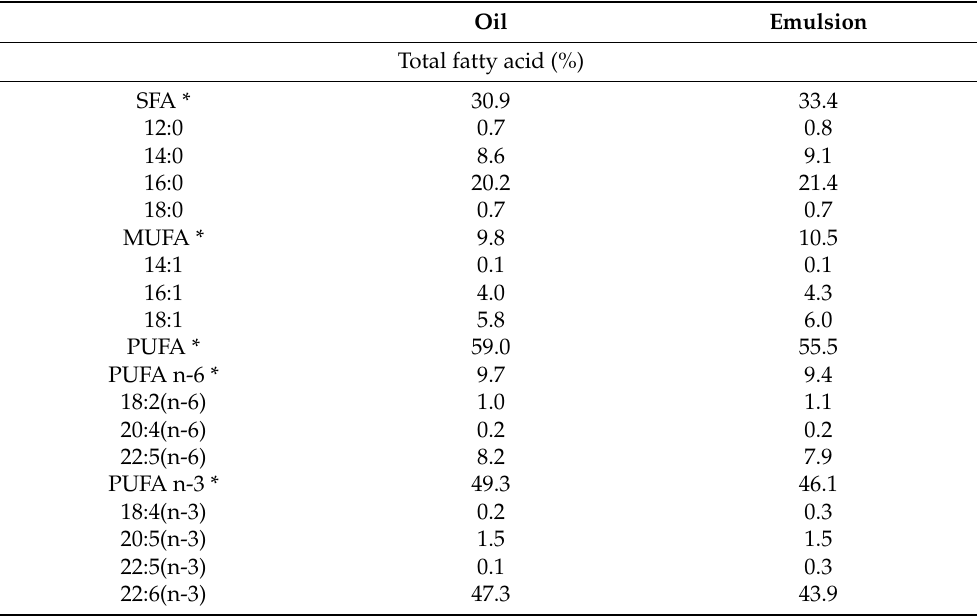
Table 1. Fatty acid profile of the oil in bulk phase and emulsified with gum acacia. Oil